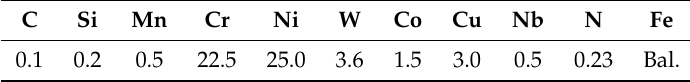
Table 1. Chemical composition of tested material (in wt.%). C Si Mn Cr Ni W Co Cu Nb N Fe 0.1 0.2 0.5 22.5